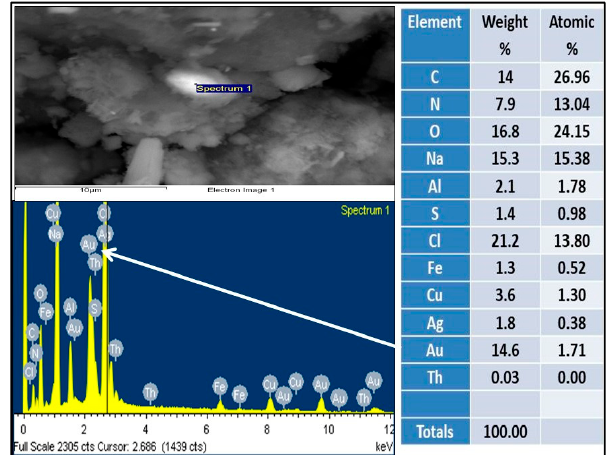
Figure 7. Chemical composition of the solid product according to SEM, and presence of gold on the surface of aluminum hydroxide.